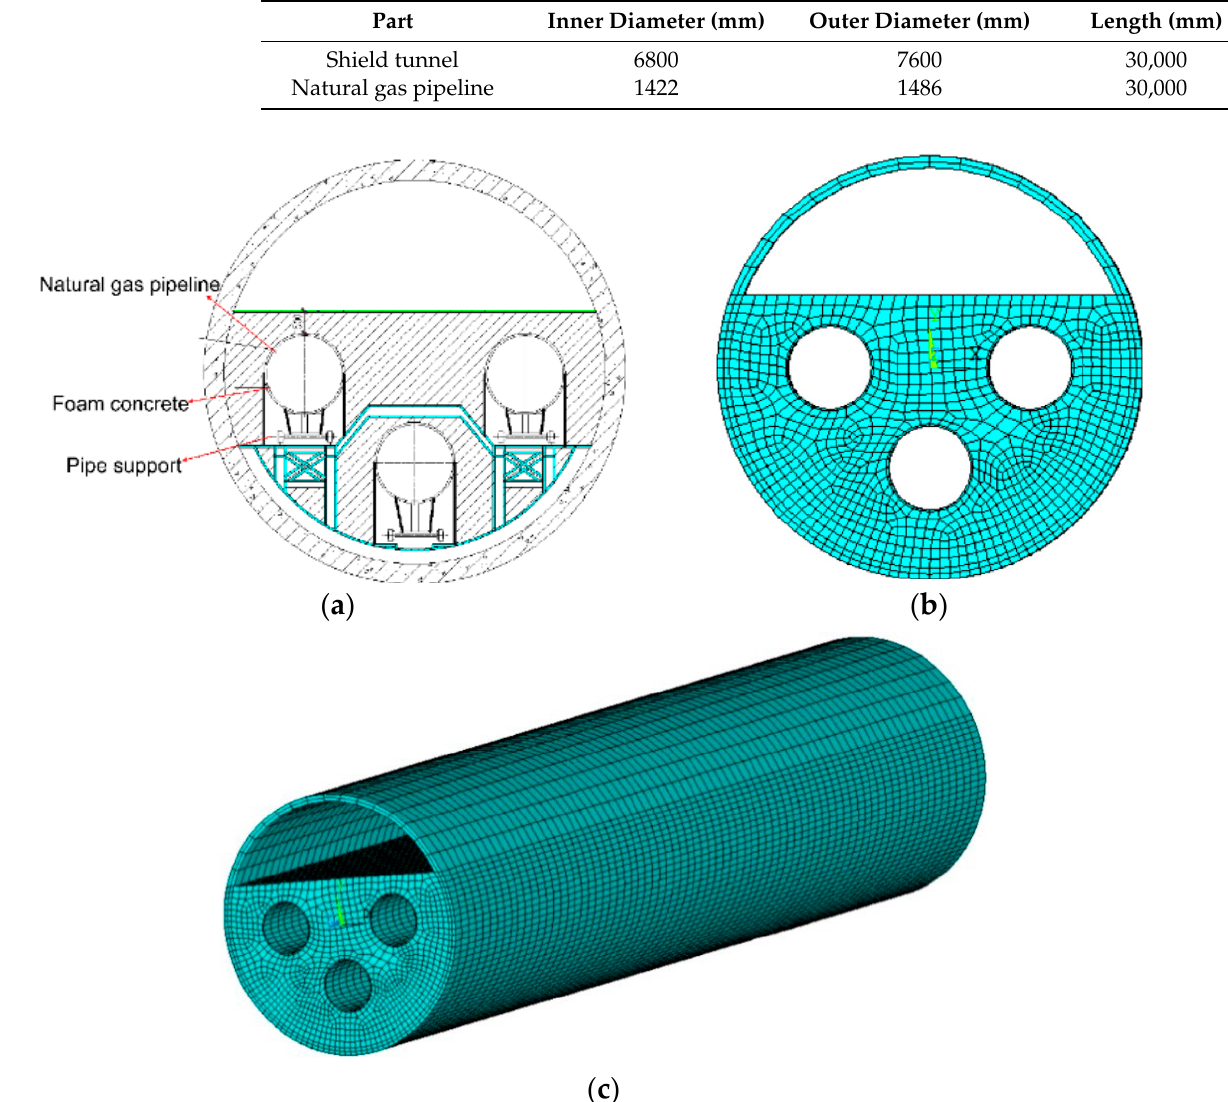
Figure 13. ( a ) Schematic diagram of shield tunnel section; ( b , c ) Finite element model of foam concrete filled tunnel.